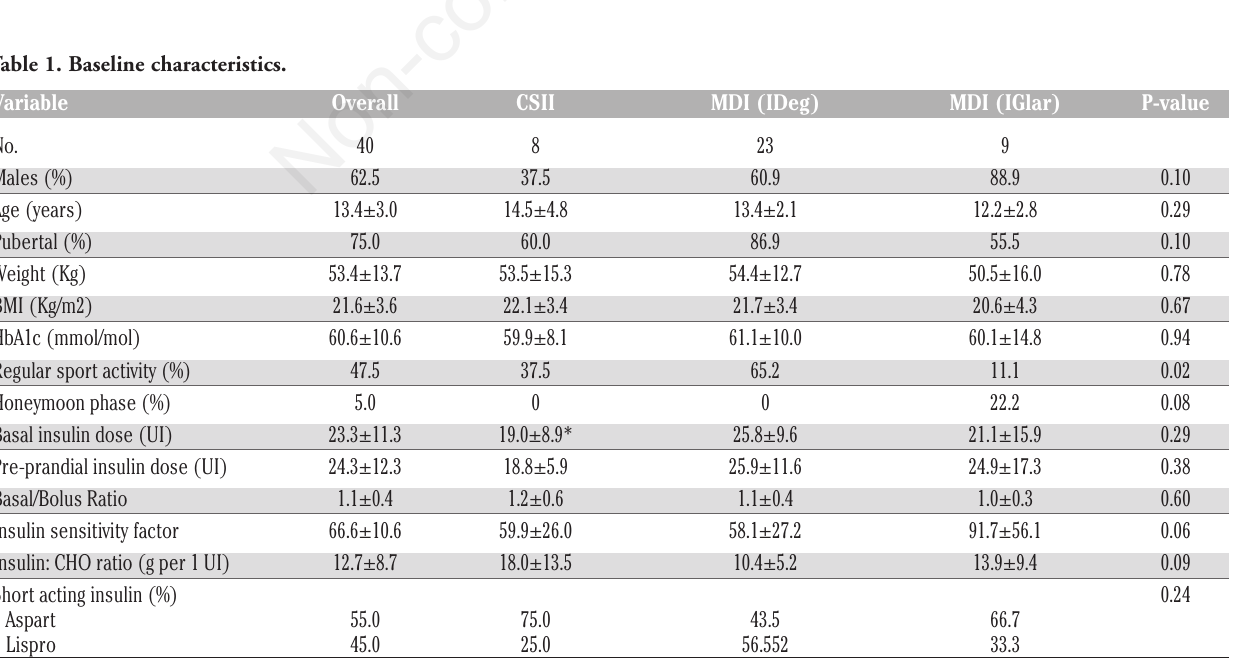
Table 1. Baseline characteristics.